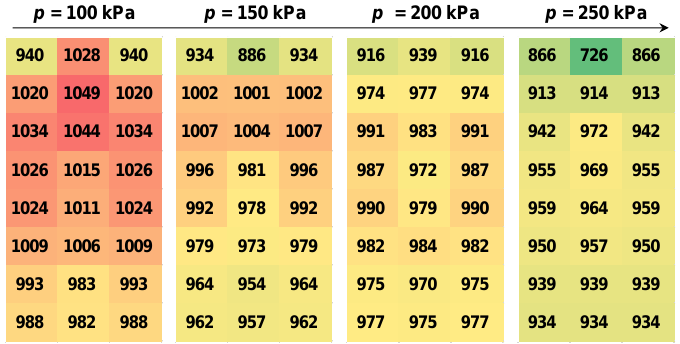
S = 4.56 and ϕ = 0.8.